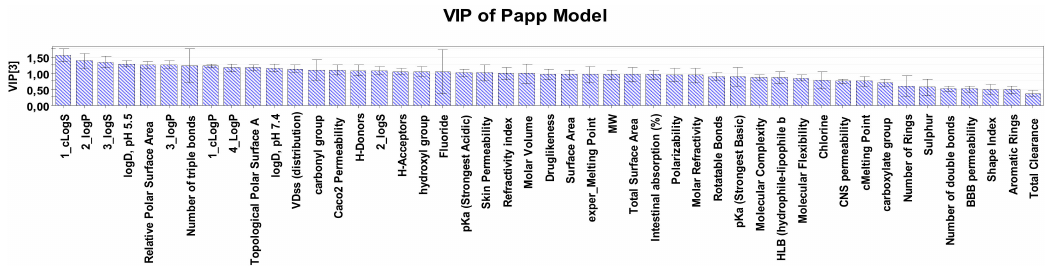
Figure 3. Variables’ Importance in the Projection (VIP) plot for the apparent permeability P values of model P, at 95% confidence level.